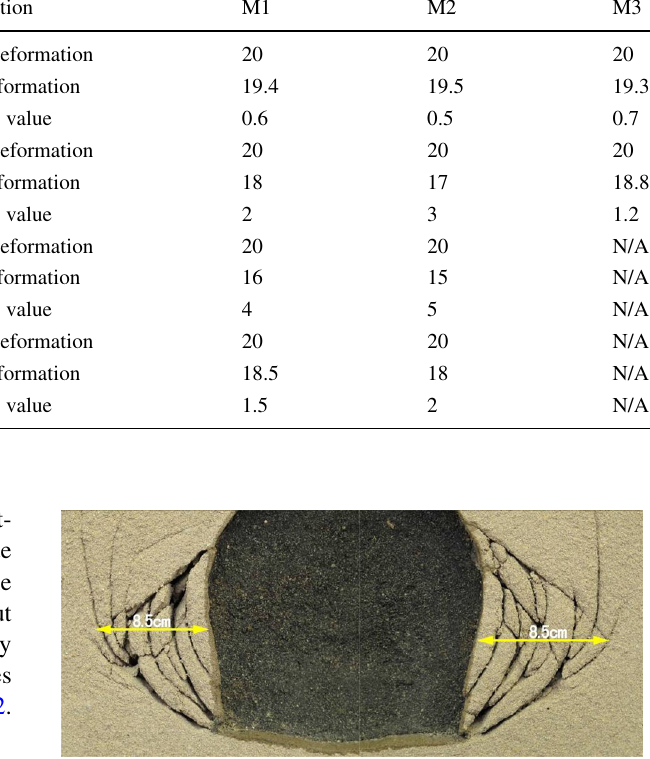
Table 2 Comparison of the deformation dimensions between the model tunnels Item